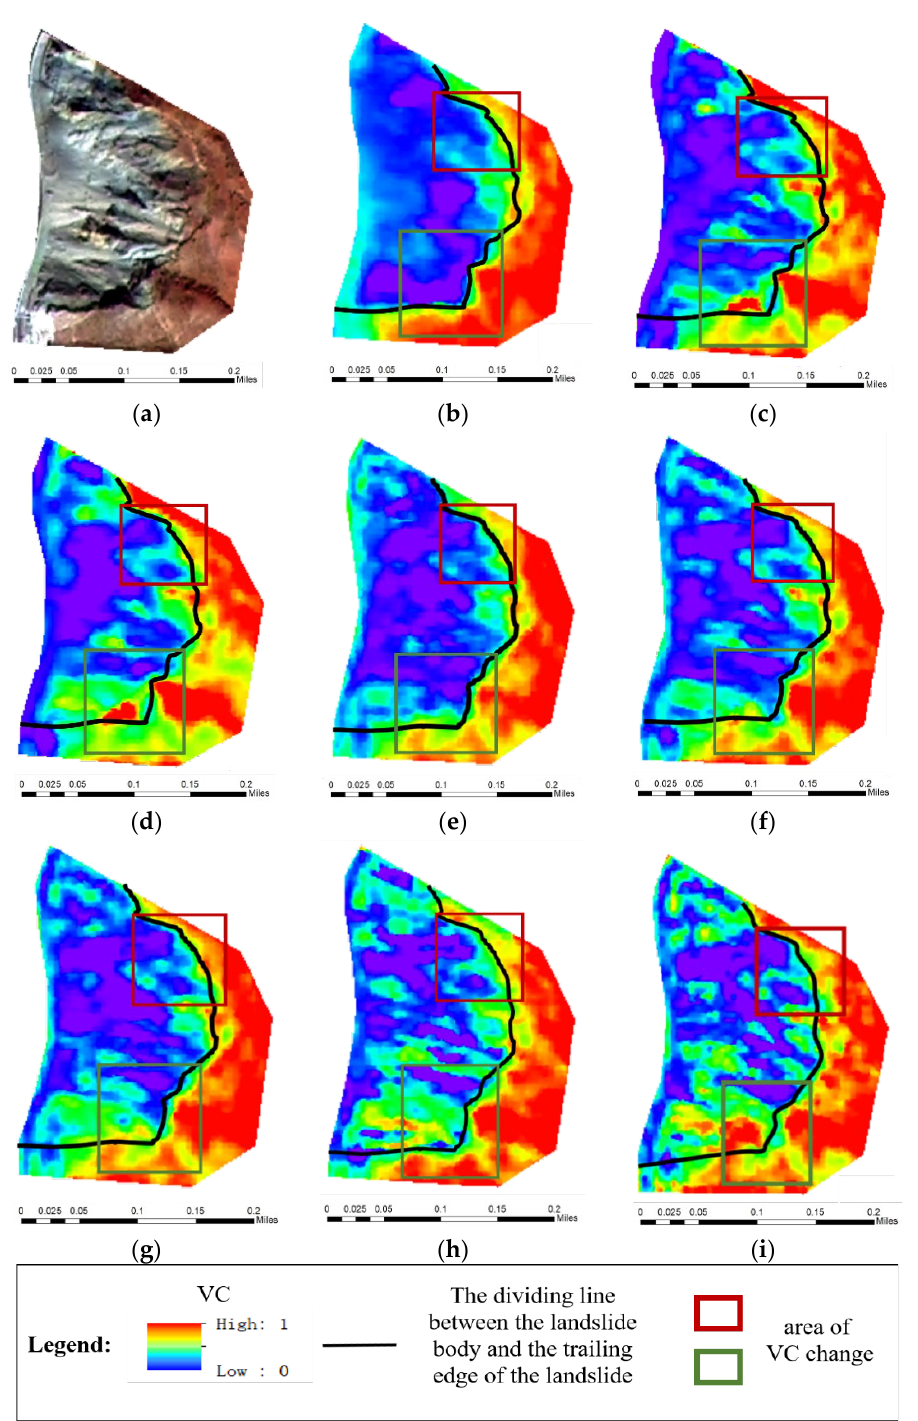
Figure 5. Pseudo-color VC maps in the upper of the Jizong Shed-Tunnel landslide. ( a ) Optical GF-1 fused true color image; ( b ) VC Map in 2013; ( c ) VC Map in 2014; ( d ) VC Map in 2015; ( e ) VC Map in 2016; ( f ) VC Map in 2017; ( g ) VC Map in 2018; ( h ) VC Map in 2019; ( i ) VC Map in 2020.